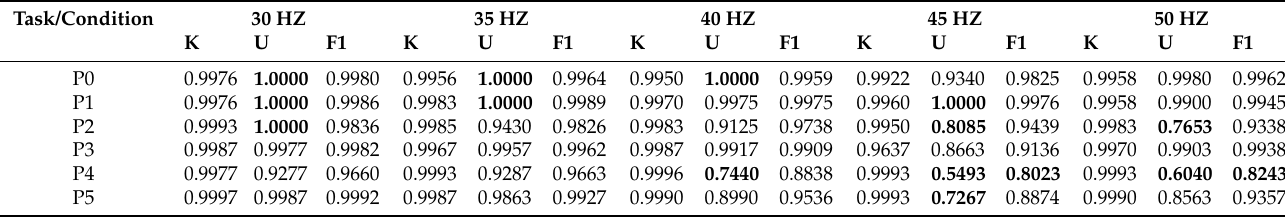
Table 9. Experimental results of the PHM2009